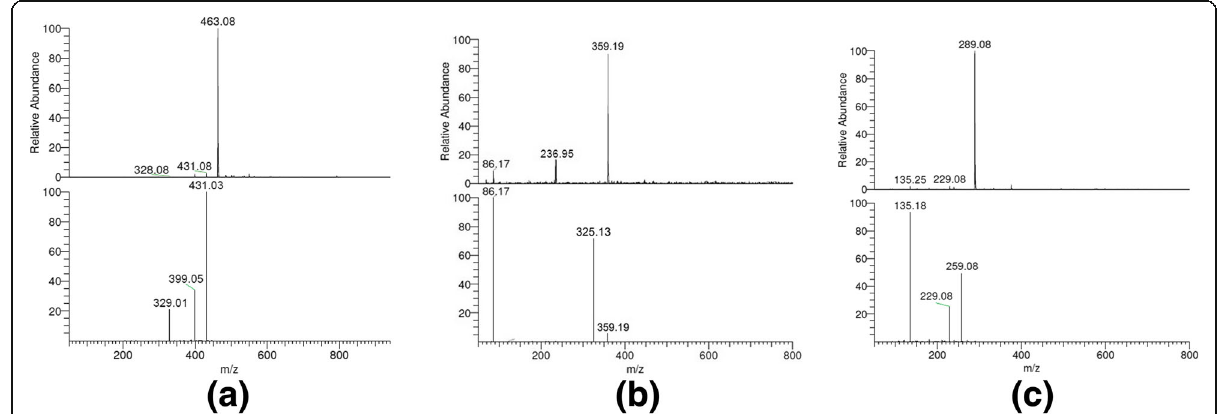
Fig. 5 LC-MS and LC-MS/MS spectra of a DP I, b DP II, and c DP